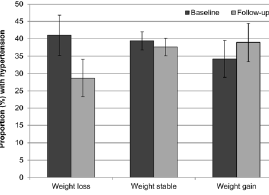
Figure 4. Prevalence of hypertension at baseline and follow-up by weight change status. Values are mutually adjusted for age, sex, wealth, and weight loss intention. Error bars represent the 95% confidence interval.